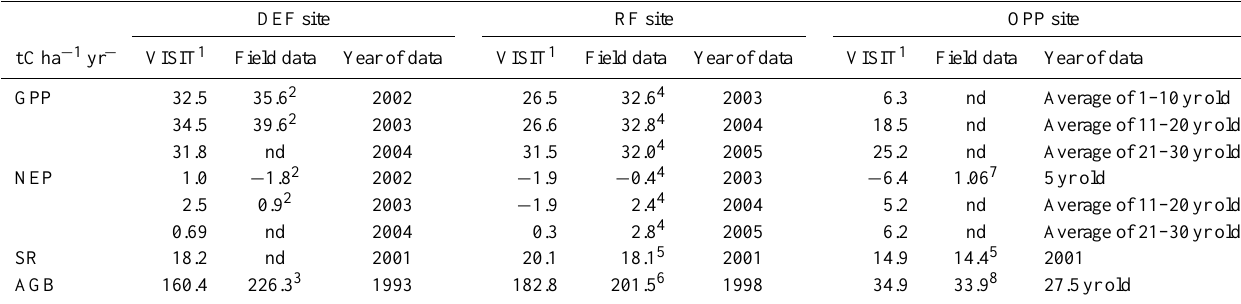
Table 4. Comparisons of gross primary production (GPP), net ecosystem production (NEP), soil respiration rate (SR) and aboveground biomass carbon (AGB) between the VISIT model simulations and field measurements. AGB carbon values were estimated as half of the aboveground biomass.